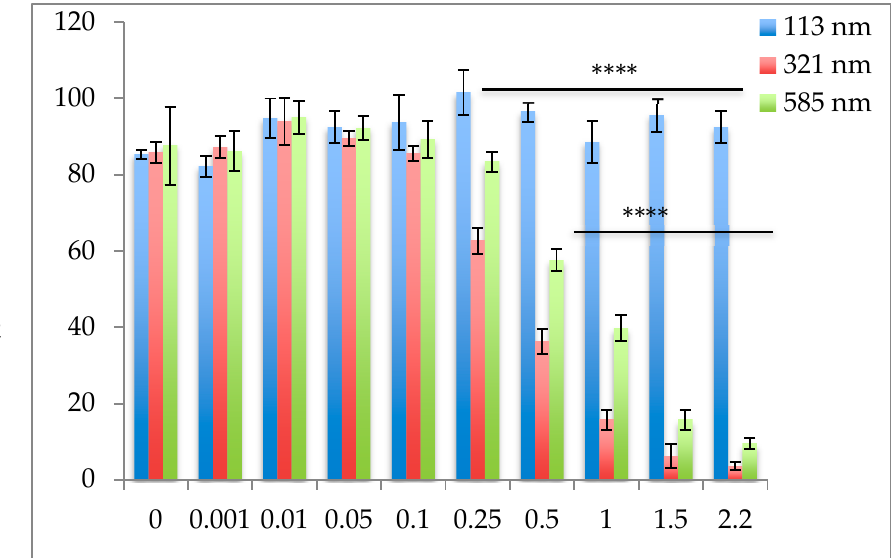
Figure 1. E ff ect of size of PLGA-PEG NPs on percent platelet aggregation (% PA) of platelets in PRP induced by ADP; ADP was added at a final concentration of 20 µ M for 12 min after incubation with PLGA-PEG NPs of di ff erent sizes for 4 min. Values are mean of n = 4–5 ± SEM. One-way ANOVA and Tukey’s multiple comparison tests were used for analysis. **** p < 0.0001 for 321 and 585 nm NPs at ≥ 0.25 and ≥ 0.50 mg / mL